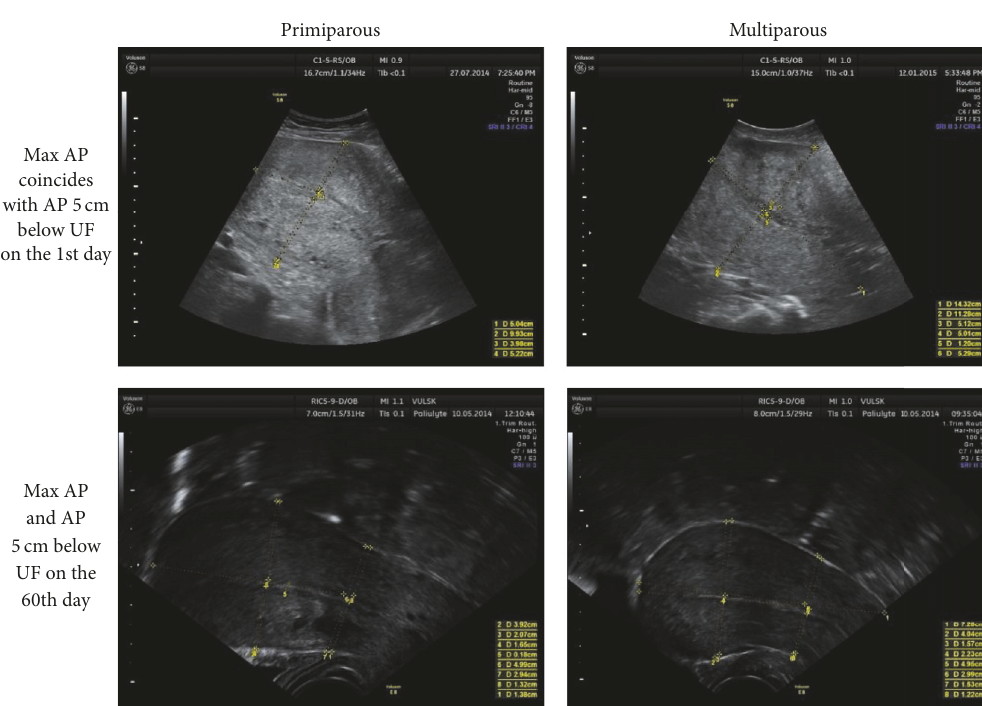
Figure 2: Max AP and AP 5 cm below UF measurements in longitudinal section.